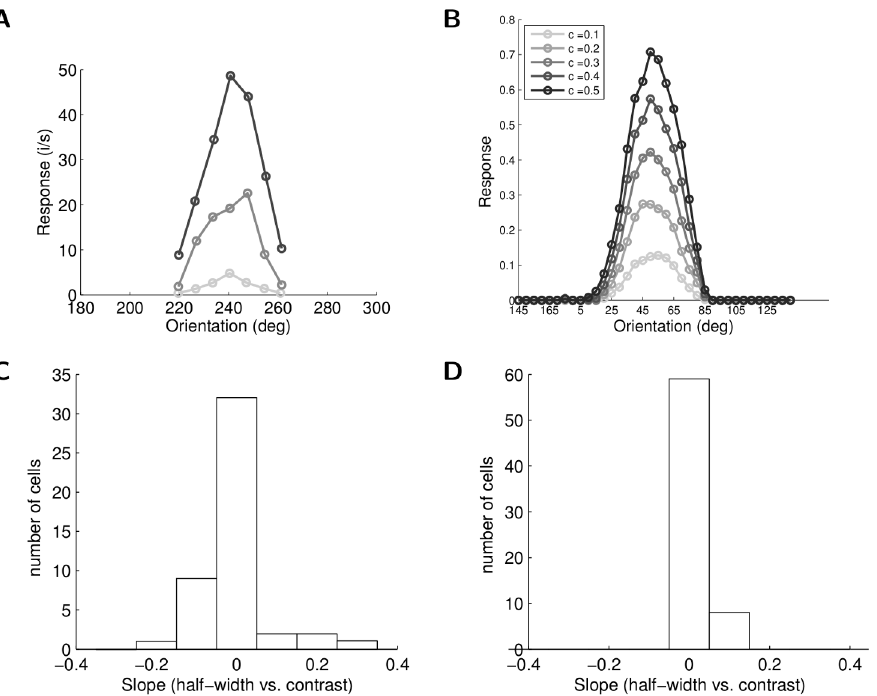
Figure 7. Contrast invariant orientation tuning. (A) Contrast invariance of orientation tuning curves recorded in cat V1 (data replotted from [46], Figure 3A). Note that the width of the orientation tuning curve does not change with contrast. (B) Sparse coding model neuron that demonstrates the same invariance property. Lighter curves correspond to lower contrast (‘‘c’’ denotes contrast level). (C) Distribution of the slope of tuning curve half-width vs. the contrast in ferret V1 (data replotted from [47], Figure 3B). The sharp distribution around 0 indicates that the tuning curve half-width is contrast invariant (mean value is 0.002). (D) Distribution of the half-width vs. the contrast slope in the sparse coding model cells (mean value is 0.032). The model cells clearly demonstrate contrast invariance of the tuning curve half-width, and an even tighter peak around zero slope than shown in (C).